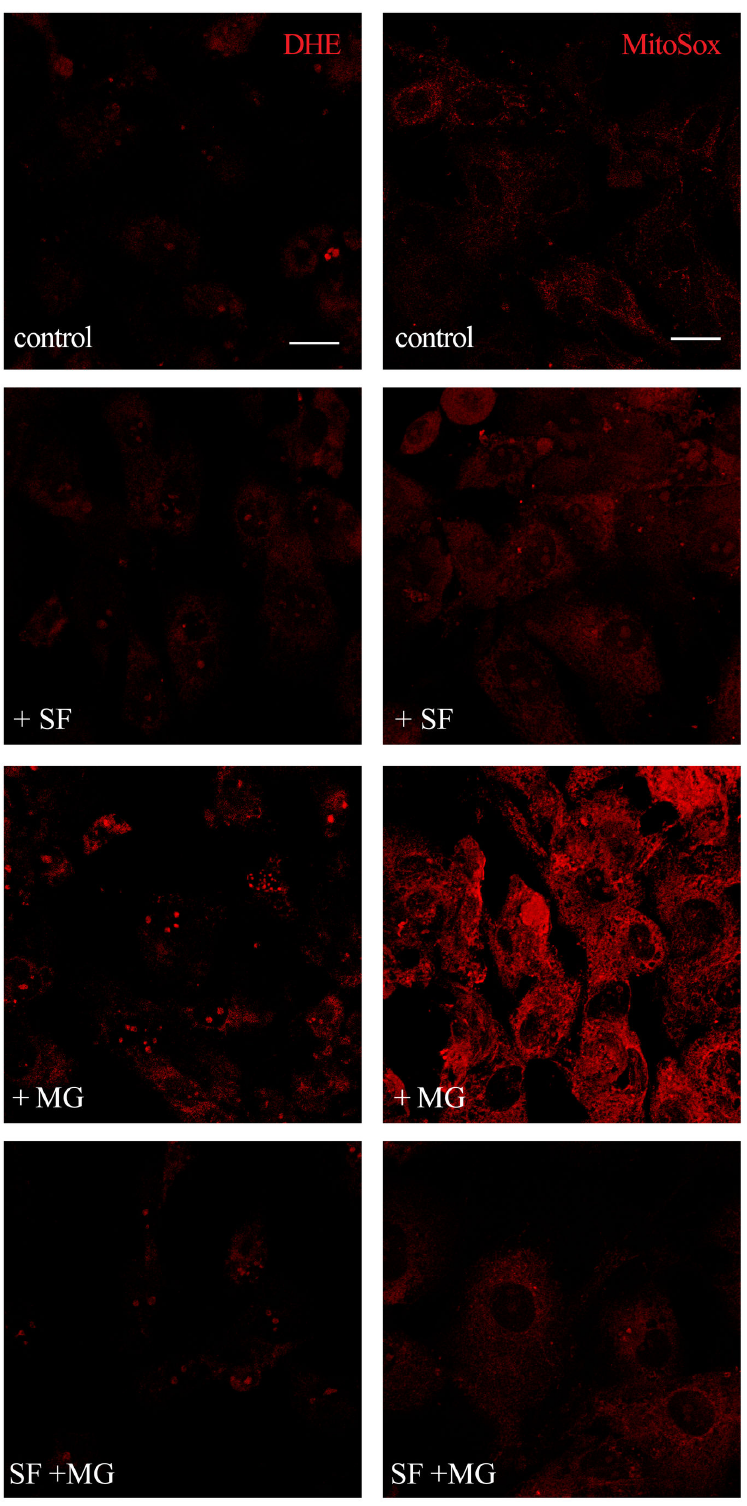
Figure 6. Confocal microscopy analysis of SF effect on MG-induced ROS production. Cardiomyocytes were treated with 5 µM SF for 24 h before the addition of 1 mM MG. Cytosolic ROS production was measured using DHE and mitochondrial ROS production by MitoSOX staining. Scale bar: 10 µm. doi: 10.1371/journal.pone.0083283.g006 PLOS ONE |